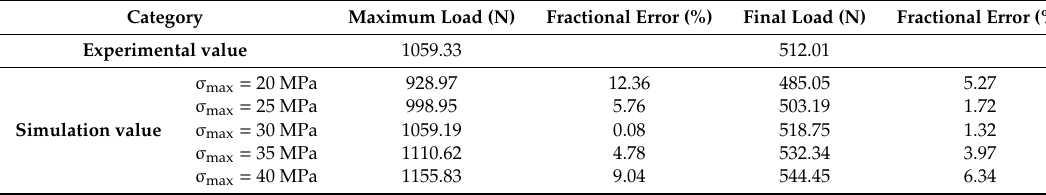
Figure 12. Damage of the first element at the edge of the brazing seam. Figure 13. Traction distribution along the edge of the brazing seam at different damage stages of crack initiation.